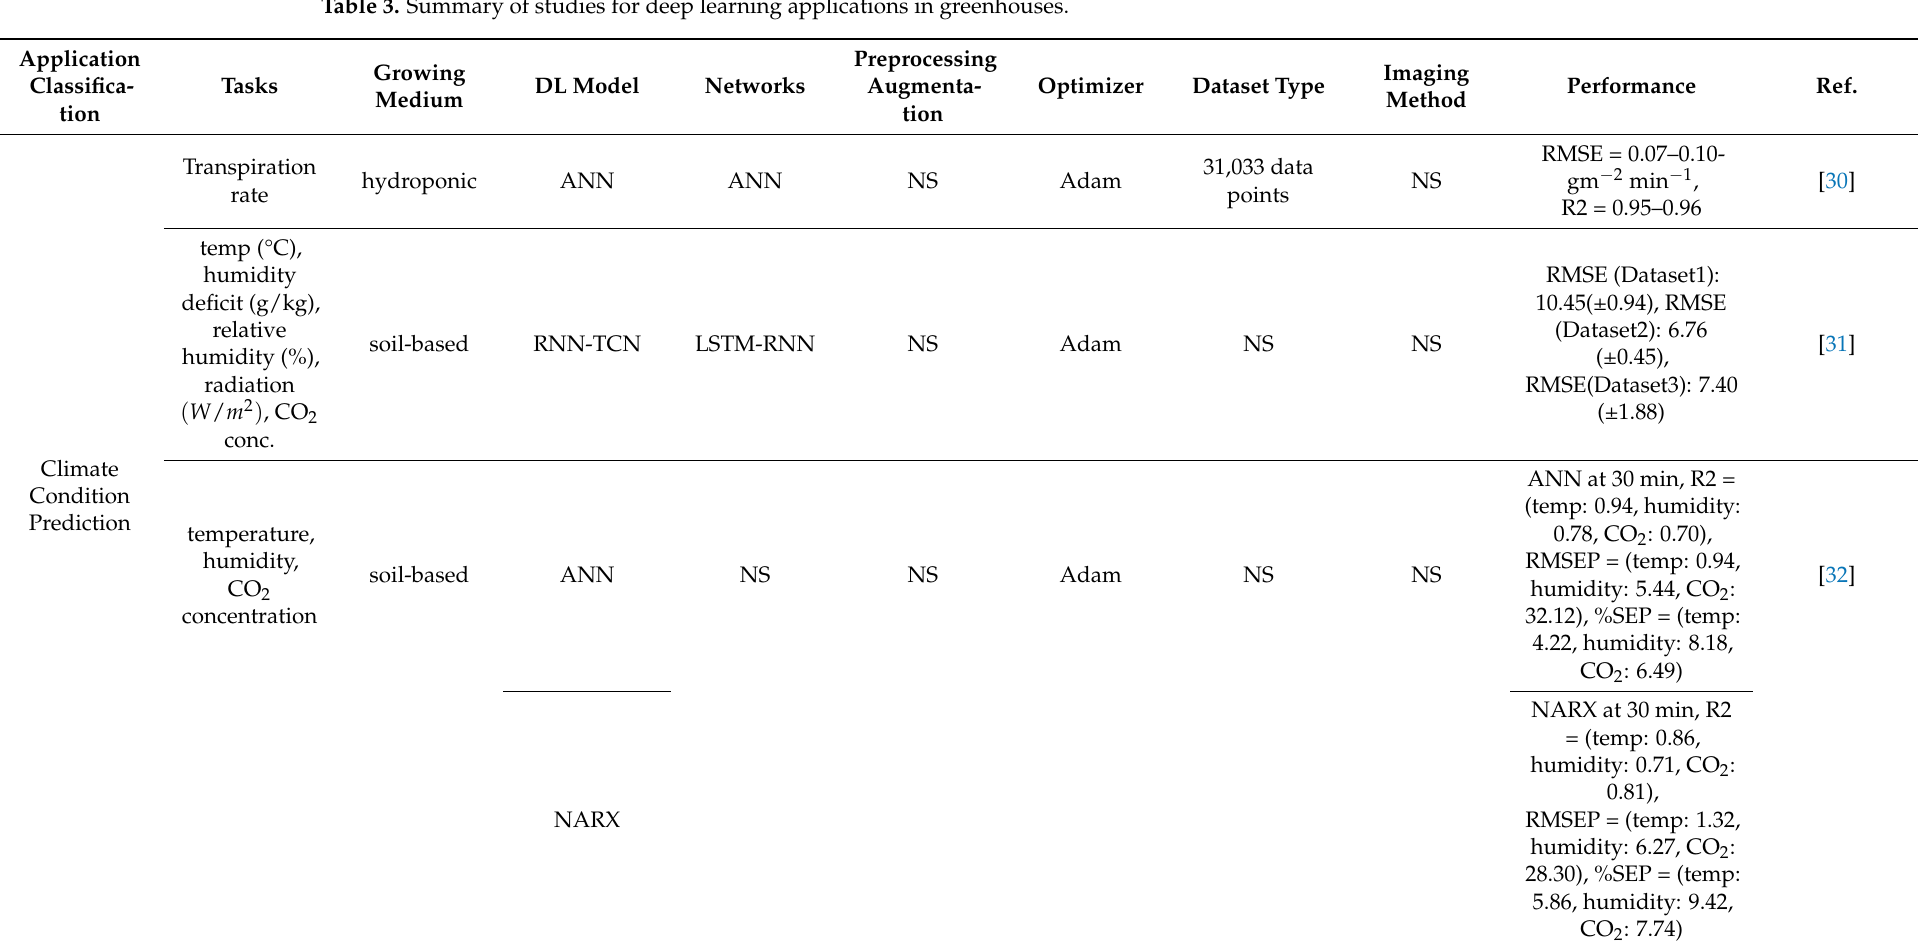
Table 3. Summary of studies for deep learning applications in